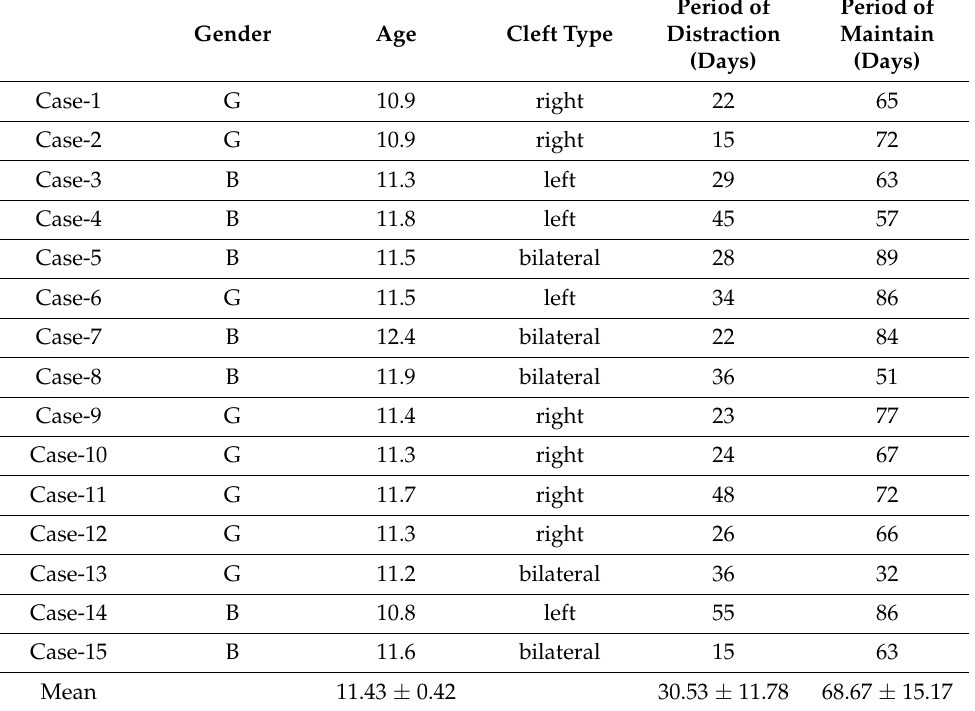
Table 2. Classification and Treatment Duration of the 15 Participants in this Study. Abbreviations: B, Boy; G,